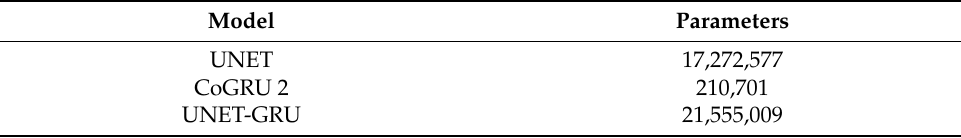
Table 1. Number of parameters of the compared